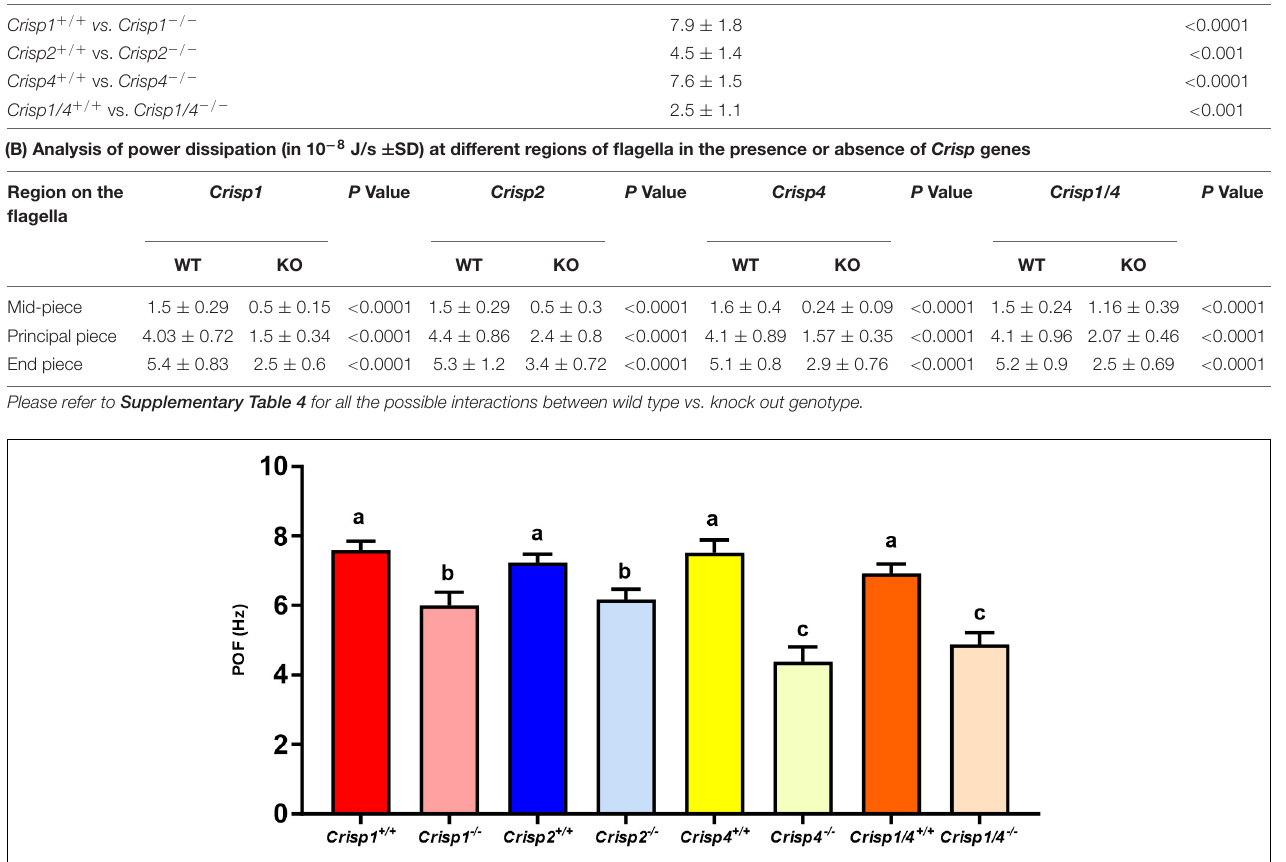
FIGURE 2 | The calculated primary oscillating frequency (POF) for sperm from wild type and Crisp knock out mice. The data presented is 25–30 sperm/genotype. N = 5–6 mice/genotype. Different letters indicate significant differences between groups, where significance is measured relative to the strain-specific wild type. P < 0.01 for all marked “b”; and P < 0.001 for all marked “c” as determined using a two-way ANOVA. The intense color bars represent Crisp wild type mice data and lighter version of the same color bars represents Crisp knock out mice data, respectively (CRISP1 – red, CRISP2 – blue, CRISP4 – yellow, and CRISP1/4 – orange).